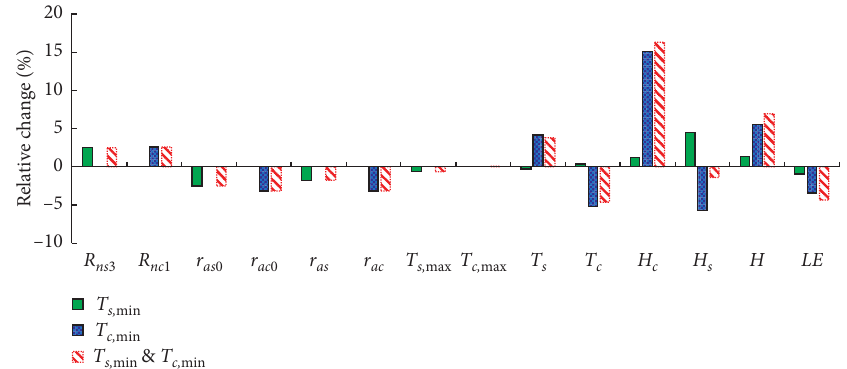
Figure 9: Relative changes in variables in the WiTSEB with the decrease in T